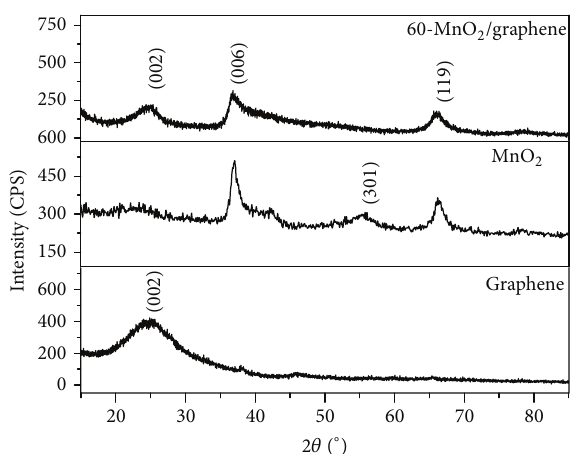
Figure 4: XRD patterns of graphene, MnO 2 , and 60-MnO 2 /graphe- ne.